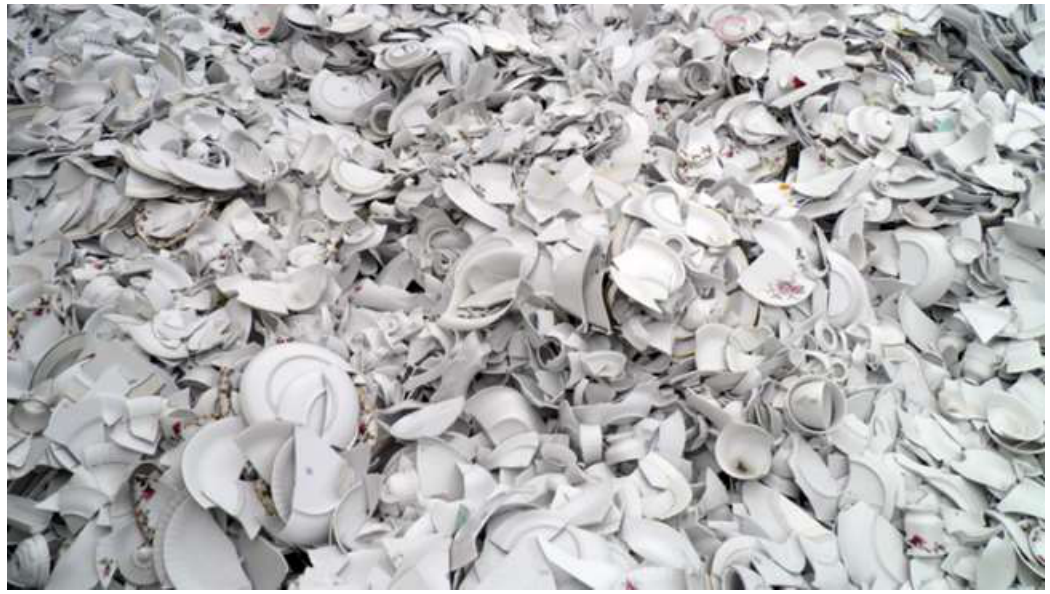
Figure 3. Crushed ceramic pots (waste white ceramics) [24].